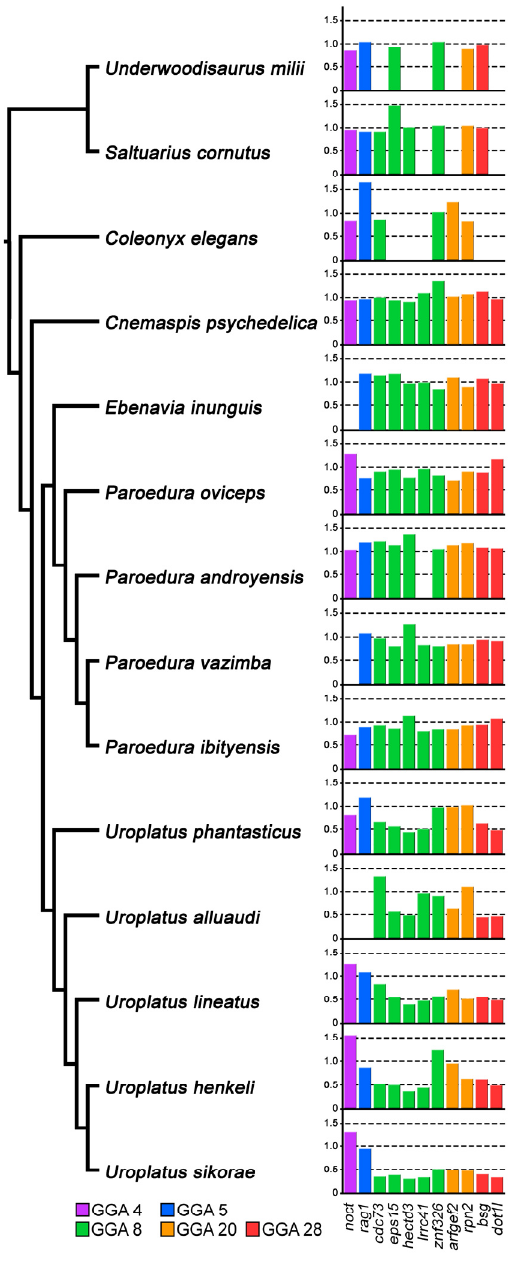
Figure 4. Gene dose ratios between sexes for 11 genes (2 autosomal and 9 linked to Z chromosome in the genus Uroplatus ) across 14 species of geckos. We expect rations of ∼ 1.00 for autosomal and pseudoautosomal genes, and ∼ 0.5 for Z-specific genes. Missing bars indicate that the specific gene was not successfully amplified by qPCR in the given species. Phylogenetic branching patterns are according to [25,53]. All data are available in Table S3.